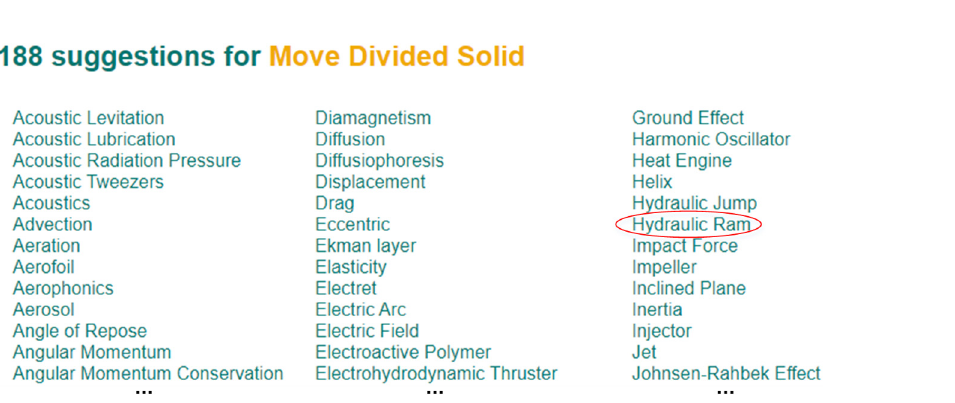
Figure 21. Effect of Moving divided solid.